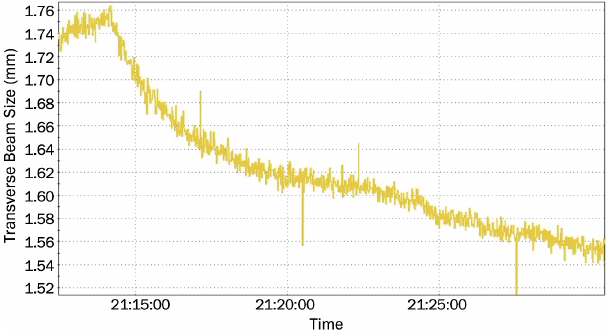
FIG. 9. Effects of different radius values on the algorithm ’ s behaviors. For a small radius r ¼ 10 (left column), the objective function is still sensitive to changes (e.g., sample 10 to 14). But compared with the original objective (see Fig. 8), the process has become more stable (e.g., sample 7 to 10). For a large radius r ¼ 30 (right column), the objective function becomes too insensitive. It is unable to change properly according to the inputs. As the inputs step through the entire range (top right), the objective values do not change with a proper scale (bottom right). Both cases should be avoided as they do not provide correct system information for the algorithm to learn.